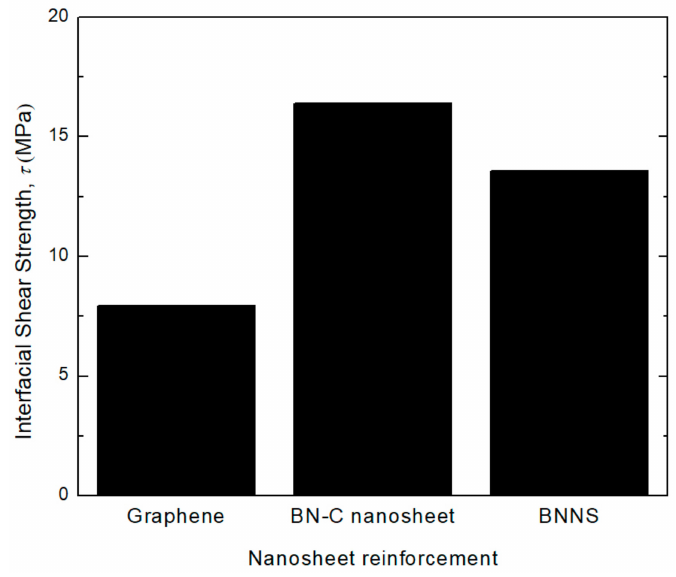
Figure 13. Interfacial shear strength of the nanosheet type reinforcement on the PE